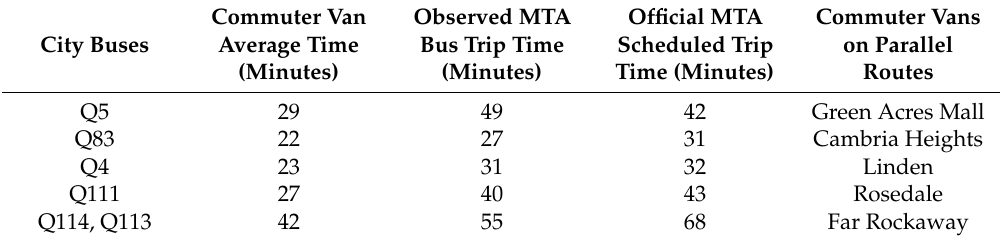
Table 4. Travel time comparison between commuter vans and city